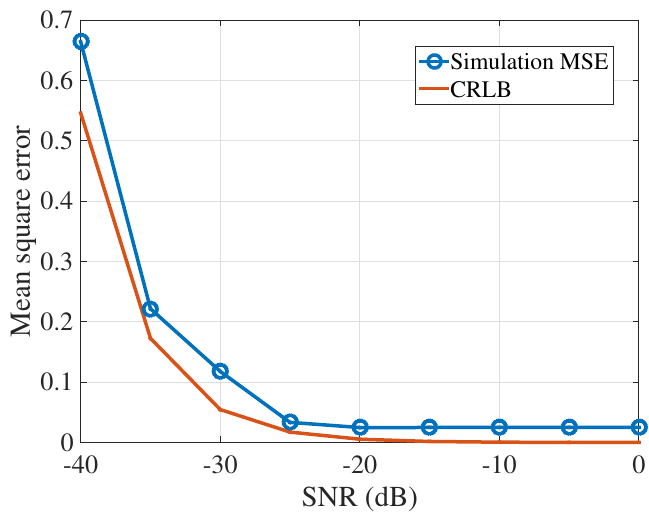
Figure 7. The CRLB and the simulation MSE of the proposed method.